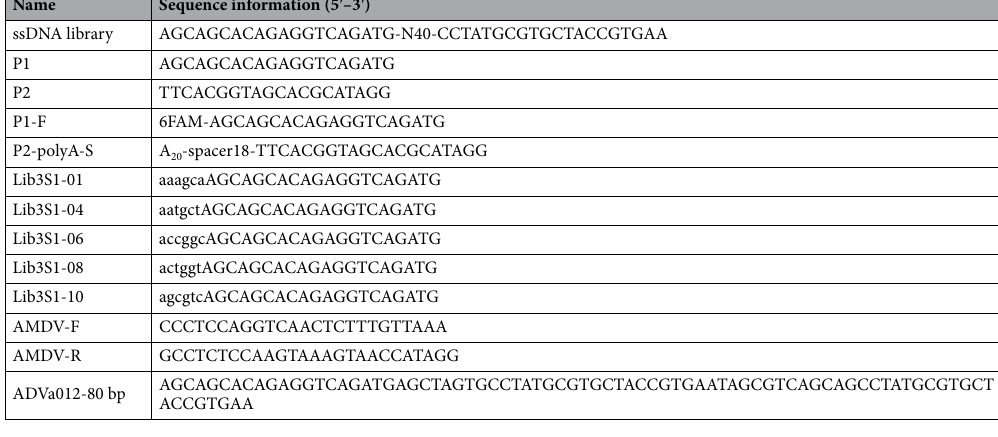
Table 2. Names and sequences of ssDNA library and oligonucleotide